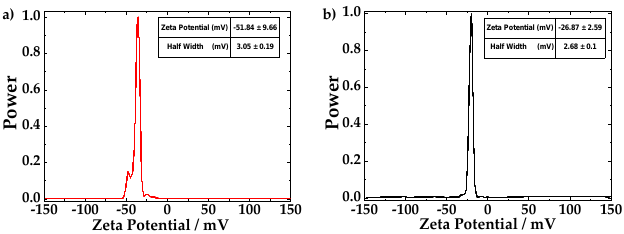
Figure 5. The zeta potential curve of ( a ) fCNTs and ( b ) ZrO 2 -fCNTs in an aqueous